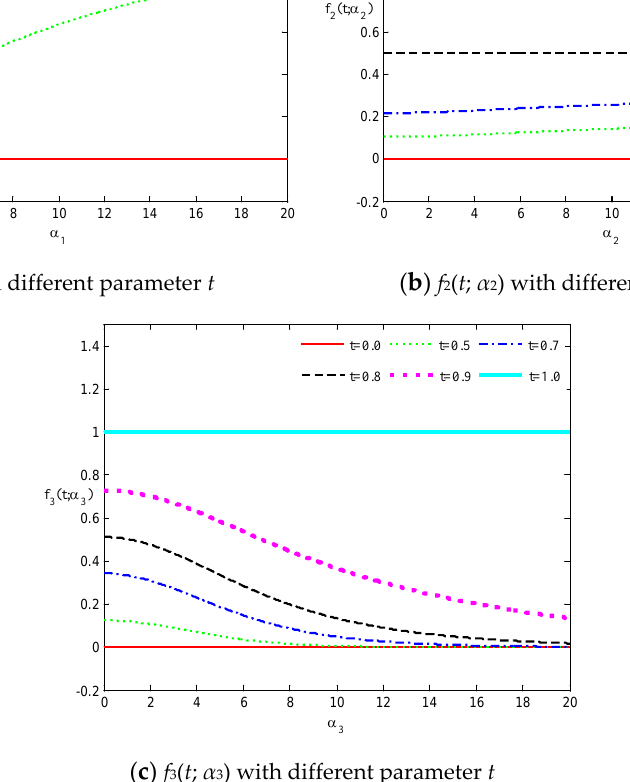
Figure 2. The translational speed functions with different parameters t .